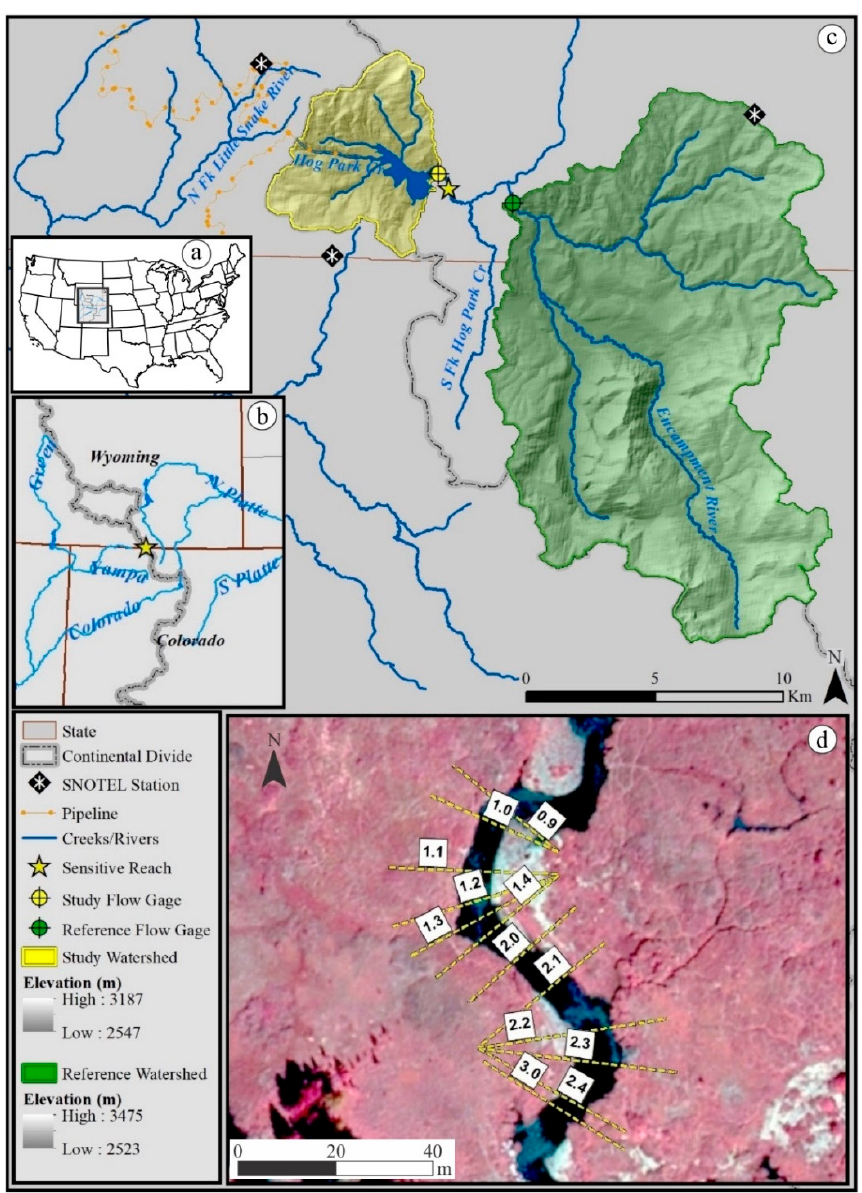
Figure 1. ( a ) The states of Wyoming and Colorado located within USA. ( b ) An inset map of the Hog Park study site area in the states of Wyoming and Colorado, USA; Continental Divide; and major rivers. ( c ) An overview map of the study and reference watersheds, sensitive reach, SNOTEL niveo-meteorological stations, Hog Park Creek, Encampment River, North Fork Little Snake River, transbasin diversion pipeline, Hog Park Reservoir, study watershed flow gage, and reference watershed flow gage. ( d ) A planform view of the sensitive reach of the study watershed selected for geometry surveys including cross-sections (numbers 0.9–3.0).